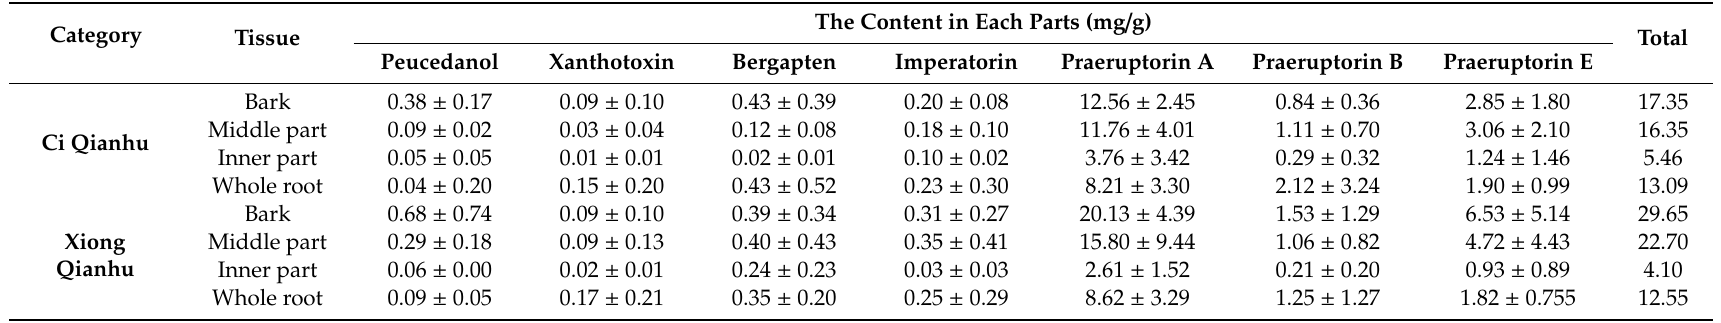
Table 2. Amount of seven chemicals in di ff erent parts of the whole transverse section from the root of Qianhu Values are means ± SD ( n =